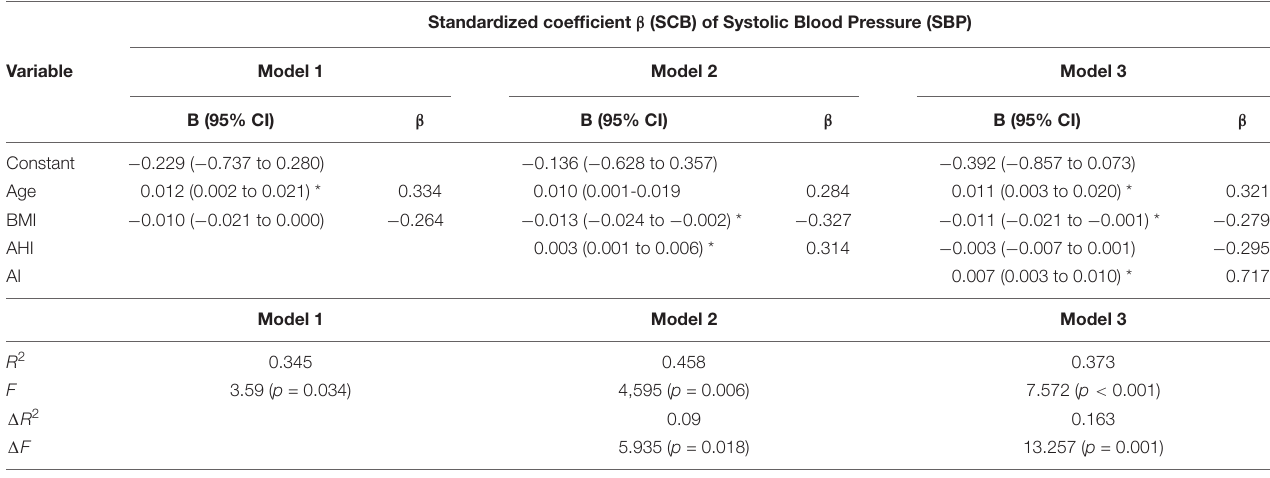
TABLE 6 | Hierarchical regression analysis of anthropometric and sleep variables for the hemodynamic standardized coefficient β prediction of systolic blood